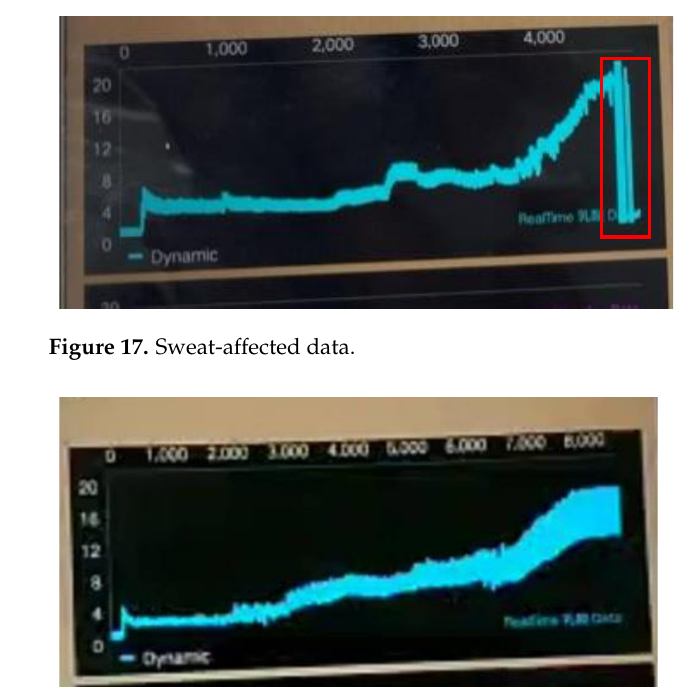
Figure 18. Data unaffected by sweat.